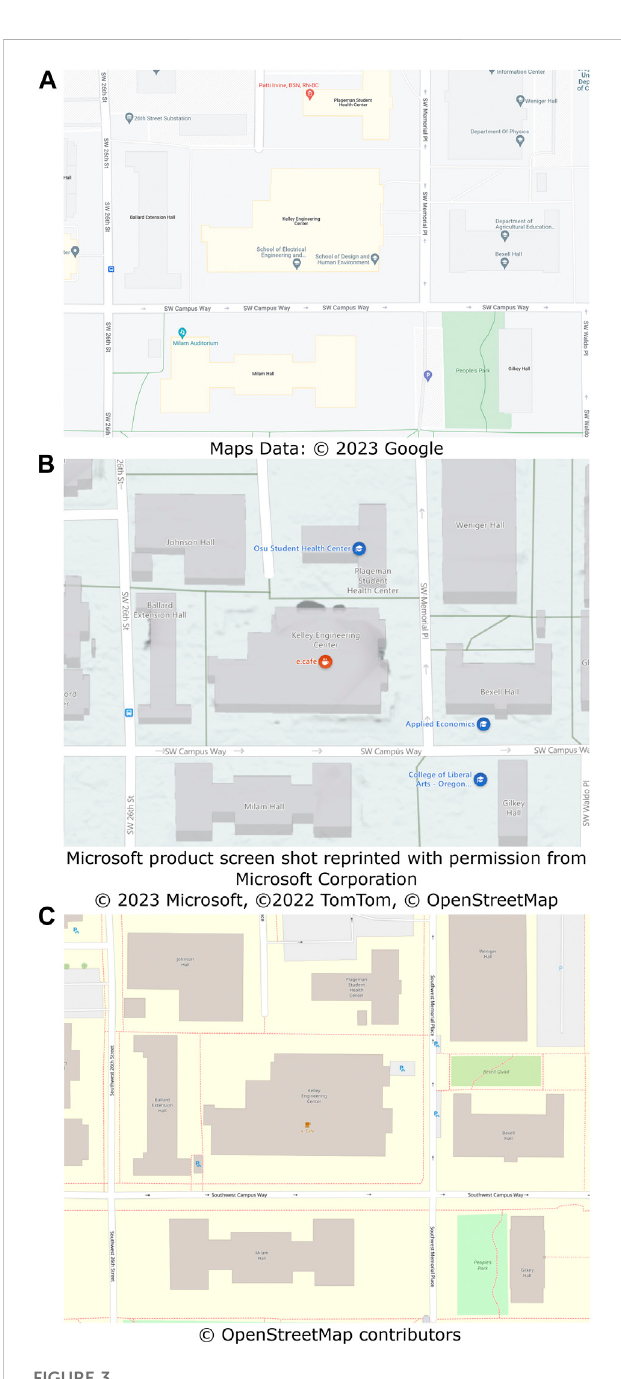
FIGURE 3 Comparison between the possible sources of publicly